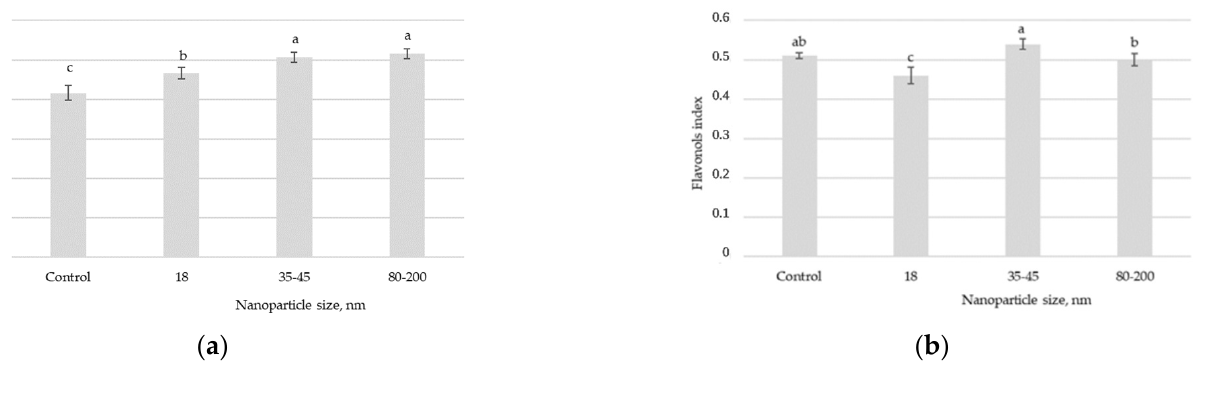
Figure 1. Particle size-dependent effects of ZnO nanoparticles on chlorophyll ( a ) and flavonol ( b ) indexes in Swiss chard. Different letters represent significant differences. The data were processed using analysis of variance (ANOVA) and the Tukey (HSD) multiple range test at the confidence level p = 0.05.